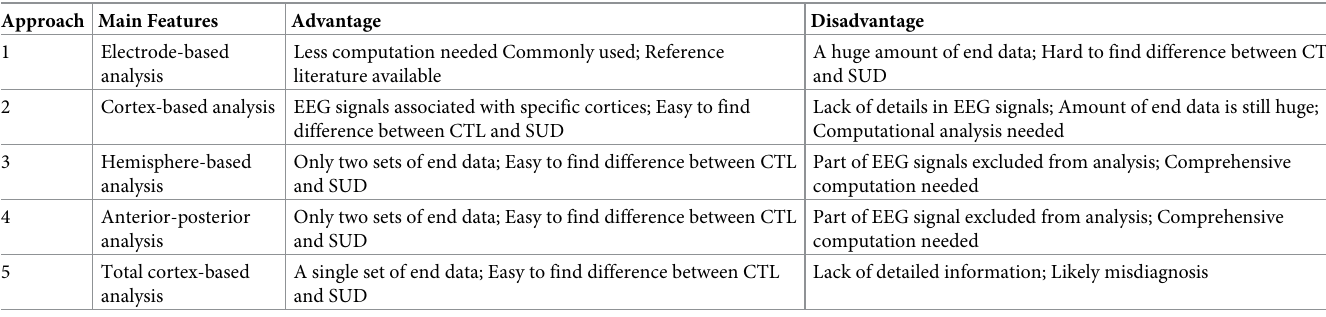
Table 2. Comparison of Approach 1–5 used in the present